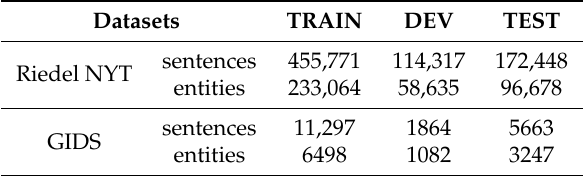
Table 1. Corpora Statistics for the Riedel New York Times (NYT) and Google IISc Distantly Supervised (GIDS)